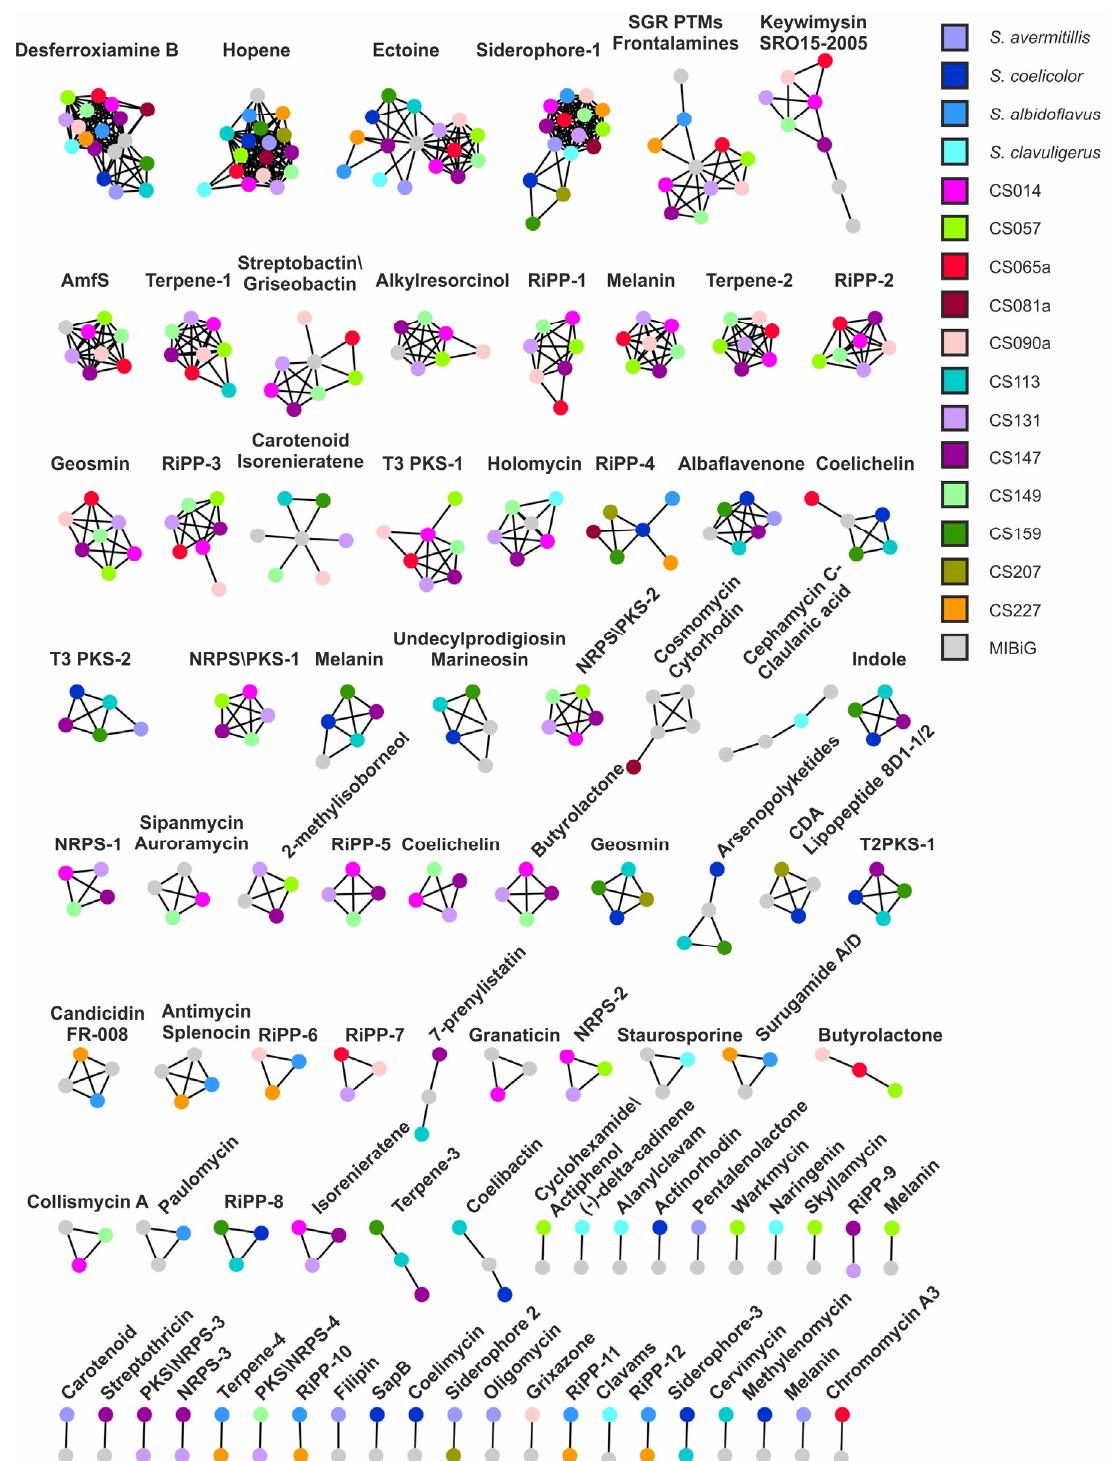
Figure 4. Similarity network generated with all secondary metabolite clusters detected by antiSMASH after manual curation. Strains are represented by dots of different